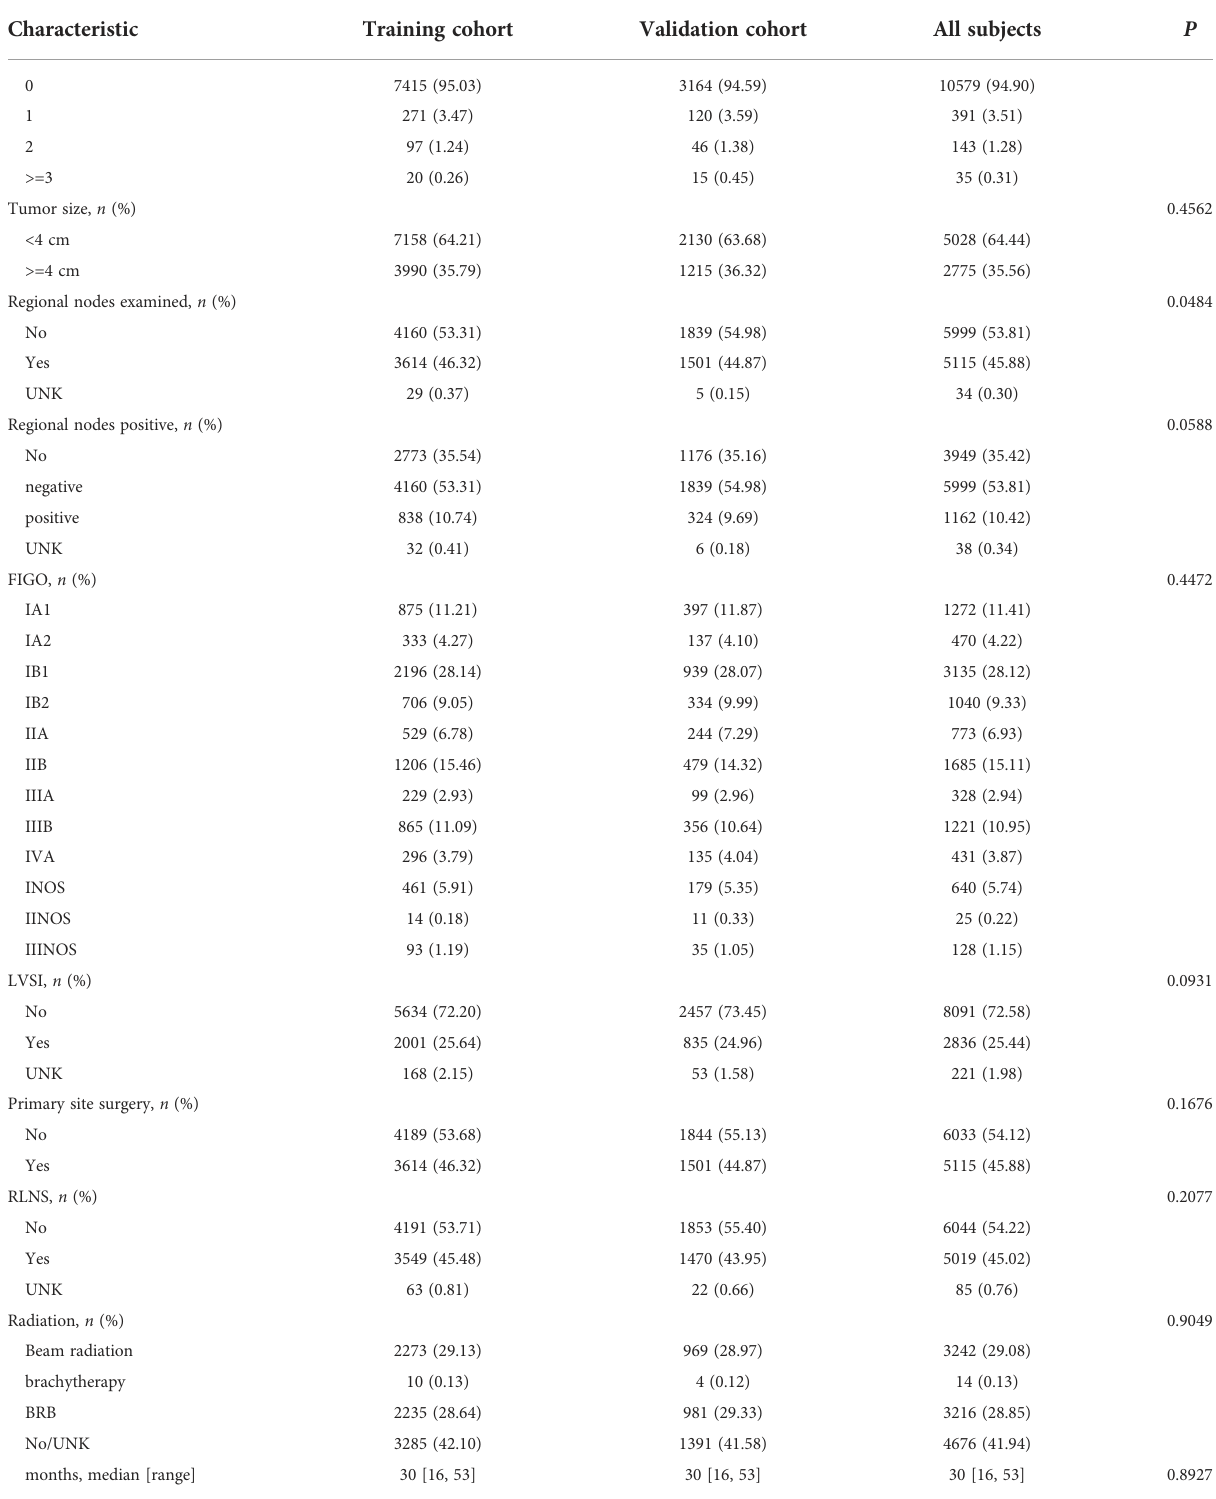
FIGO, International Federation of Gynecologists and Obstetricians; UNK, Unknown; OLC, overlap crossing; RSS, Radiation sequence with surgery; AC, adenocarcinoma; SCC, Squamous cell carcinoma; FIGO, the International Federation of Gynecology and Obstetrics; LVSI, lymph vascular space invasion; RLNS, Regional lymph node surgery; BRB, Combination of beam with